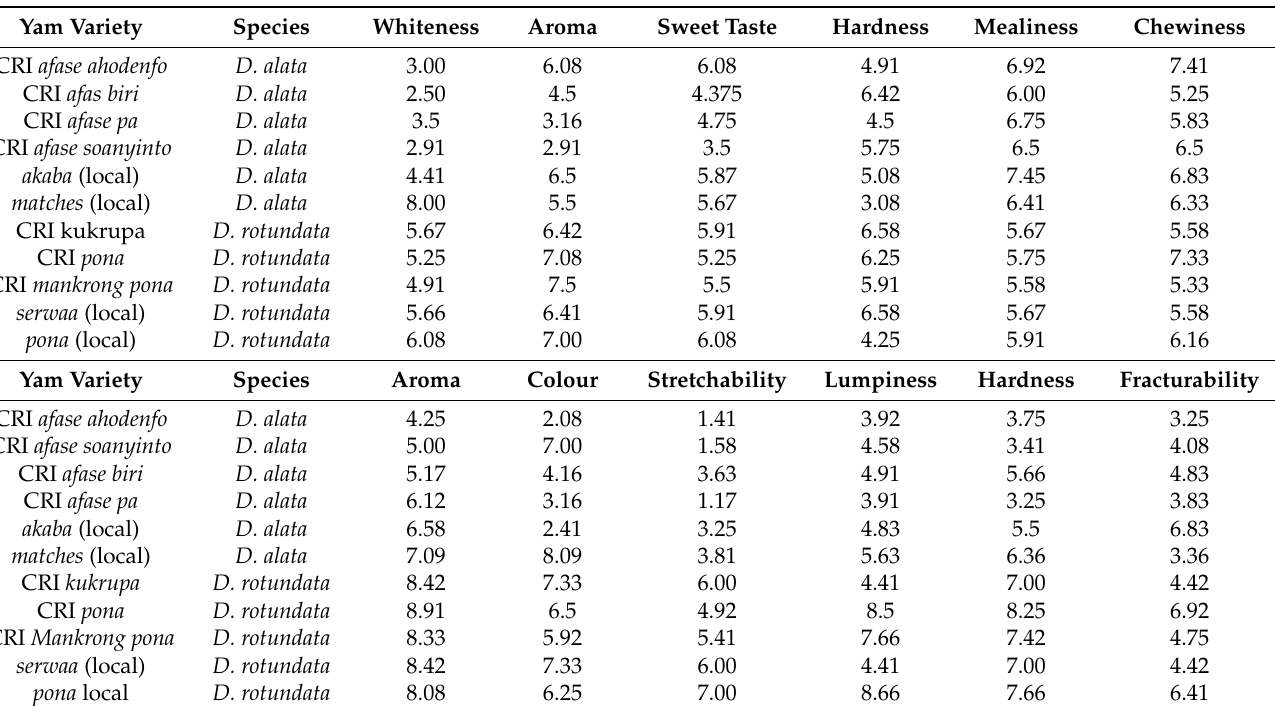
Table 2. Average scores for boiled yam from D. alata and D. rotundata yam